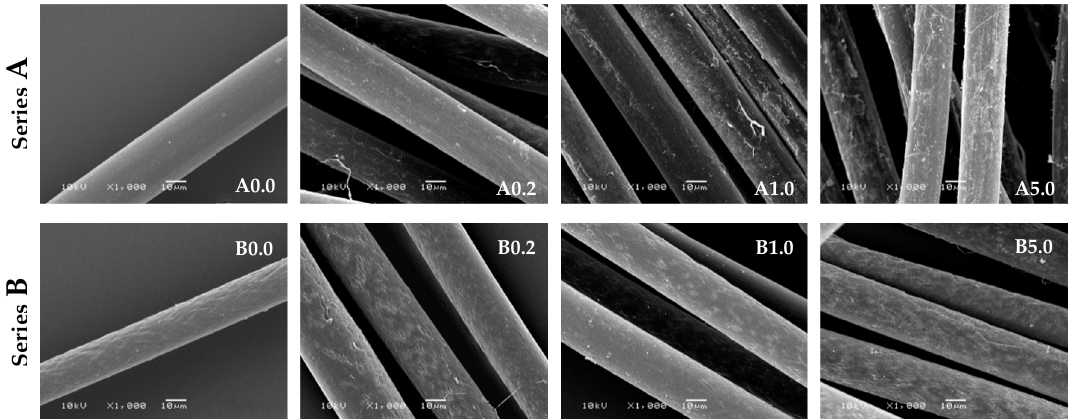
Figure 5. SEM micrographs of blends fibres before and after modification with various concentrations of AgNO 3.